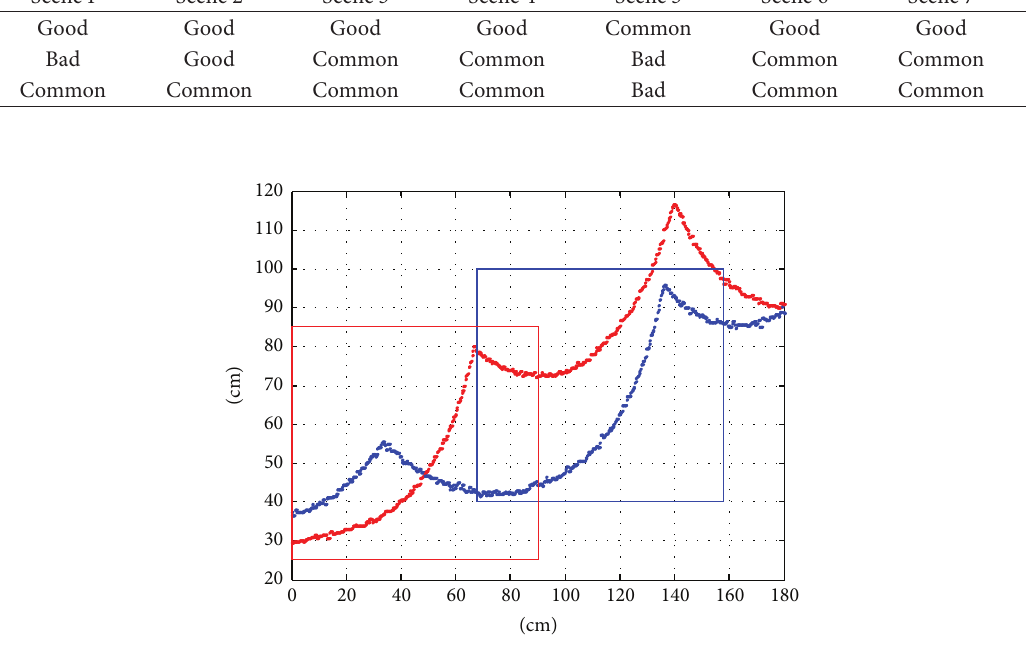
Figure 10: The curve of reference and current scan in Scene